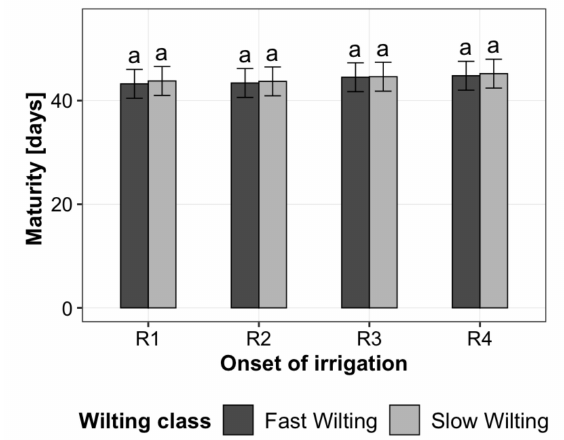
Figure 5. Maturity of each wilting class under different onset irrigations (R1, R2, R3, and R4). Same letters are not significantly different (Tukey’s; p -value < 0.05). Whiskers denote standard error of the